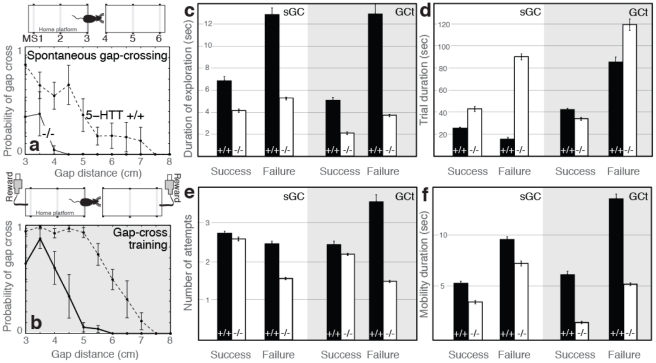
Impaired whisker function in 5-HTT KO mice.a) Top: Schematic view of the experimental set-up. Animals tried to locate a target object (i.e. platform) placed after a gap [64]. Their mobility is tracked using motion sensors. Bottom: Probability of successful object localization and subsequent gap-cross. 5-HTT deletion impairs tactile sensation (P<0.01, Kolmogorov-Smirnov test). b) Rewarded training for 3 weeks improves performance but does not rescue the whisker deficit. Top: Experimental set-up is similar to Figure 6a with the addition of computer controlled reward delivery ports. Bottom: Probability of gap-crossing (WT vs KO, P<0.01, Kolmogorov-Smirnov test). c) Duration of exploration, i.e. time spent at the gap, d) time animals required to travel between the two ends of the platform during successful trials or the delay to return to the starting position after sensory exploration at the gap during failures, e) number of attempts (i.e. visits to the gap) f) duration of mobility across genotypes and training conditions. Please refer to the text for statistical comparisons. Error terms are standard errors of the means.